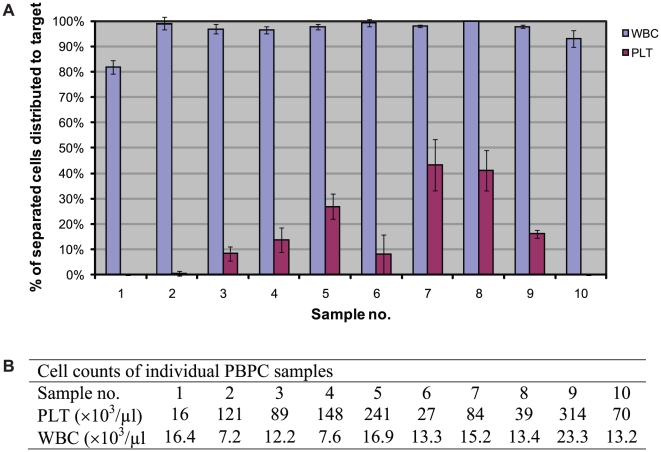
Separation efficiency of individual PBPC samples.
A) The relative numbers (expressed as %) of separated WBC and platelets, respectively, which were distributed to the target fraction are given as the mean ± SD of 6–12 sequentially collected target portions of each PBPC sample. B) The WBC and PLT counts of individual PBPC samples diluted 1∶5 before separation. Samples were obtained from 2 healthy donors (sample no. 5 and 9) and 8 patients (multiple myeloma, n = 1; non Hodgkin lymphoma, n = 4; mantle cell lymphoma, n = 1; testicular cancer, n = 1; or multiple sclerosis, n = 1).